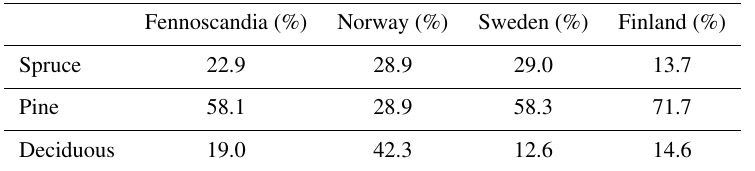
Table 3. The percentage (%) of forest pixels (i.e., excluding gapfilled pixels) belonging to different species groups in the enhanced LC product (referred to as Fennoscandia) and separately for each country (the spatial distribution of different forest subgroups and their frequency distributions are shown in Fig. 3). Values are based on MS-NFI data.